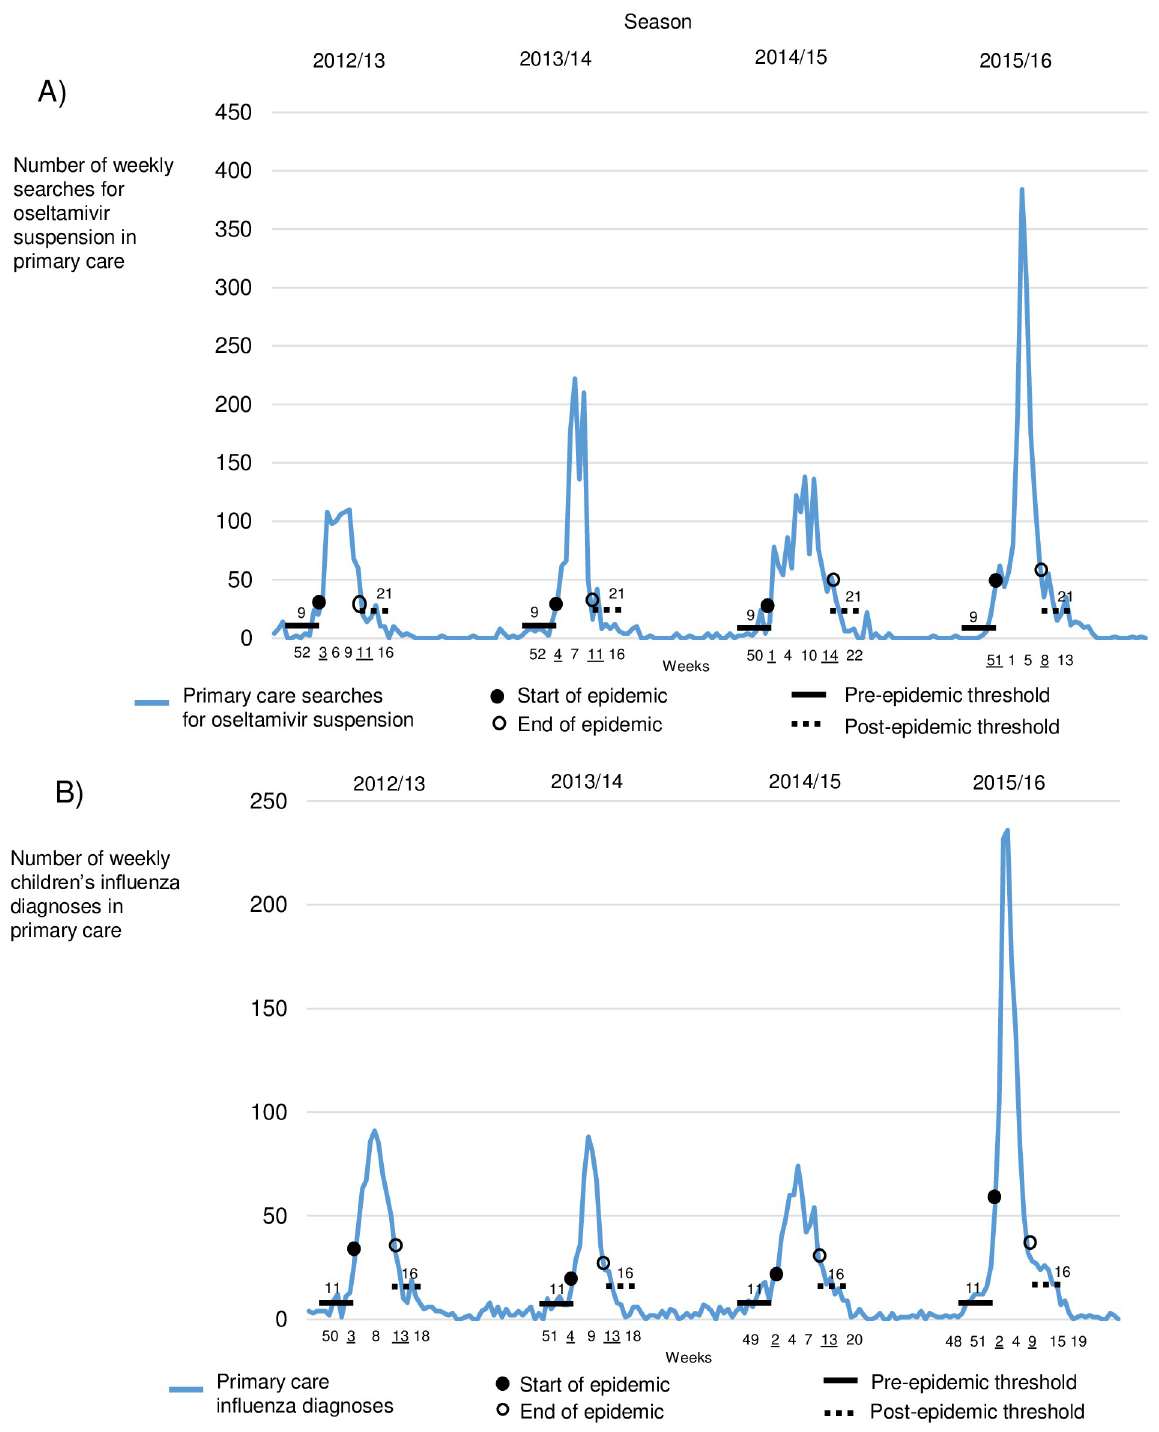
Fig 2. Primary care searches, diagnoses, and starts and ends of influenza epidemic periods (underlined weeks) across Finland during 2012–2016 by season, including pre-epidemic and post-epidemic influenza thresholds. (A) Weekly searches for oseltamivir suspension in primary care. (B) Weekly children’s influenza diagnoses in primary care.